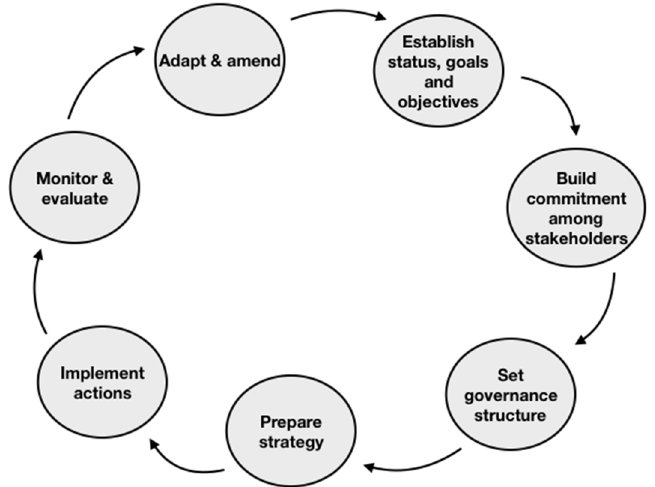
Figure 1. The Integrated Water Resources Management (IWRM) planning cycle [47,48]. (Adapted from Global Water Partnership. Integrated Water Resources Management Plans: Training Manual and Operational Guide, 2005.)